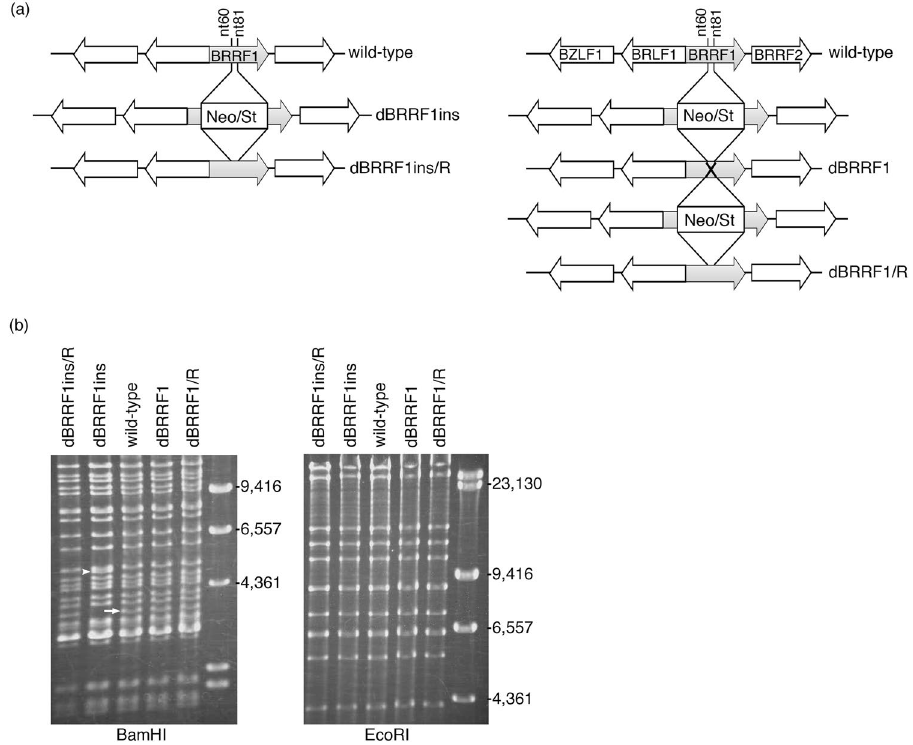
Figure 2. Construction of BRRF1-knockout EBV. ( a ) BRRF1 knockout EBV and the revertant were constructed using the BAC system in Escherichia coli 22, 25 . The Neo/St cassette, which contains neomycin resistance and streptomycin sensitivity genes, was inserted between nts 60 and 81 of the BRRF1 gene (dBRRF1ins). Then, the cassette was replaced with the original BRRF1 sequence (dBRRF1ins/R) or with a BRRF1 sequence containing two stop codons, nts 72 T > A and 76 G > T (dBRRF1). The Neo/St cassette was again inserted and replaced with the original BRRF1 sequence (dBRRF1/R). ( b ) EBV BAC DNAs were digested with BamHI or EcoRI and analysed by electrophoresis. The BamHI-R fragment of EBV is indicated by a white arrow and an arrowhead. Full-length gels are presented in Supplementary Figure